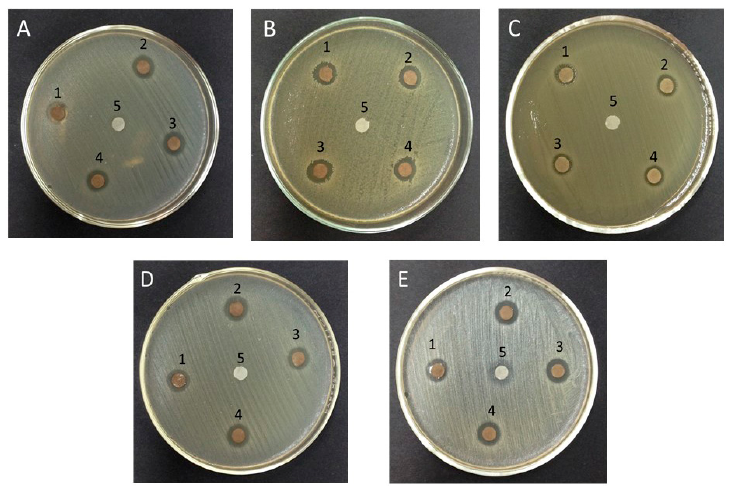
Figure 4. Antimicrobial activity against: ( A ) Streptococcus mutans , ( B ) Staphylococcus aureus , ( C ) Esch- erichia coli , ( D ) Enterococcus faecalis , ( E ) Candida albicans . Disk 1, 24 h after synthesis; disk 2, 7 days after synthesis; disk 3, 14 days after synthesis; disk 4, 21 days after synthesis; disk 5, control disk only with clove extract.